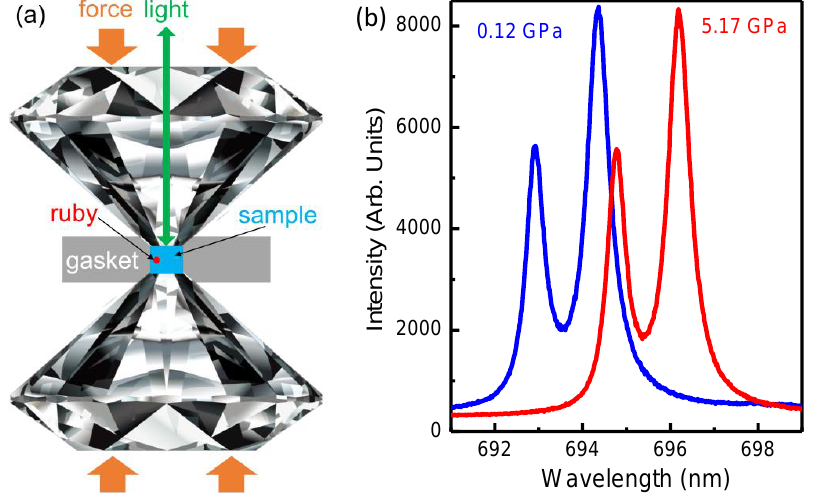
Figure 1. ( a ) Schematic of the symmetric diamond anvil cell used in these measurements. The ruby ball and the sample crystal share a high pressure environment but are not directly in contact. ( b ) Fluorescence of the annealed ruby ball when the cell was just closed (0.12 GPa) and at 5.17 GPa. The shape of the fluorescence spectra along with the separation of the two peaks is consistent with quasi-hydrostatic